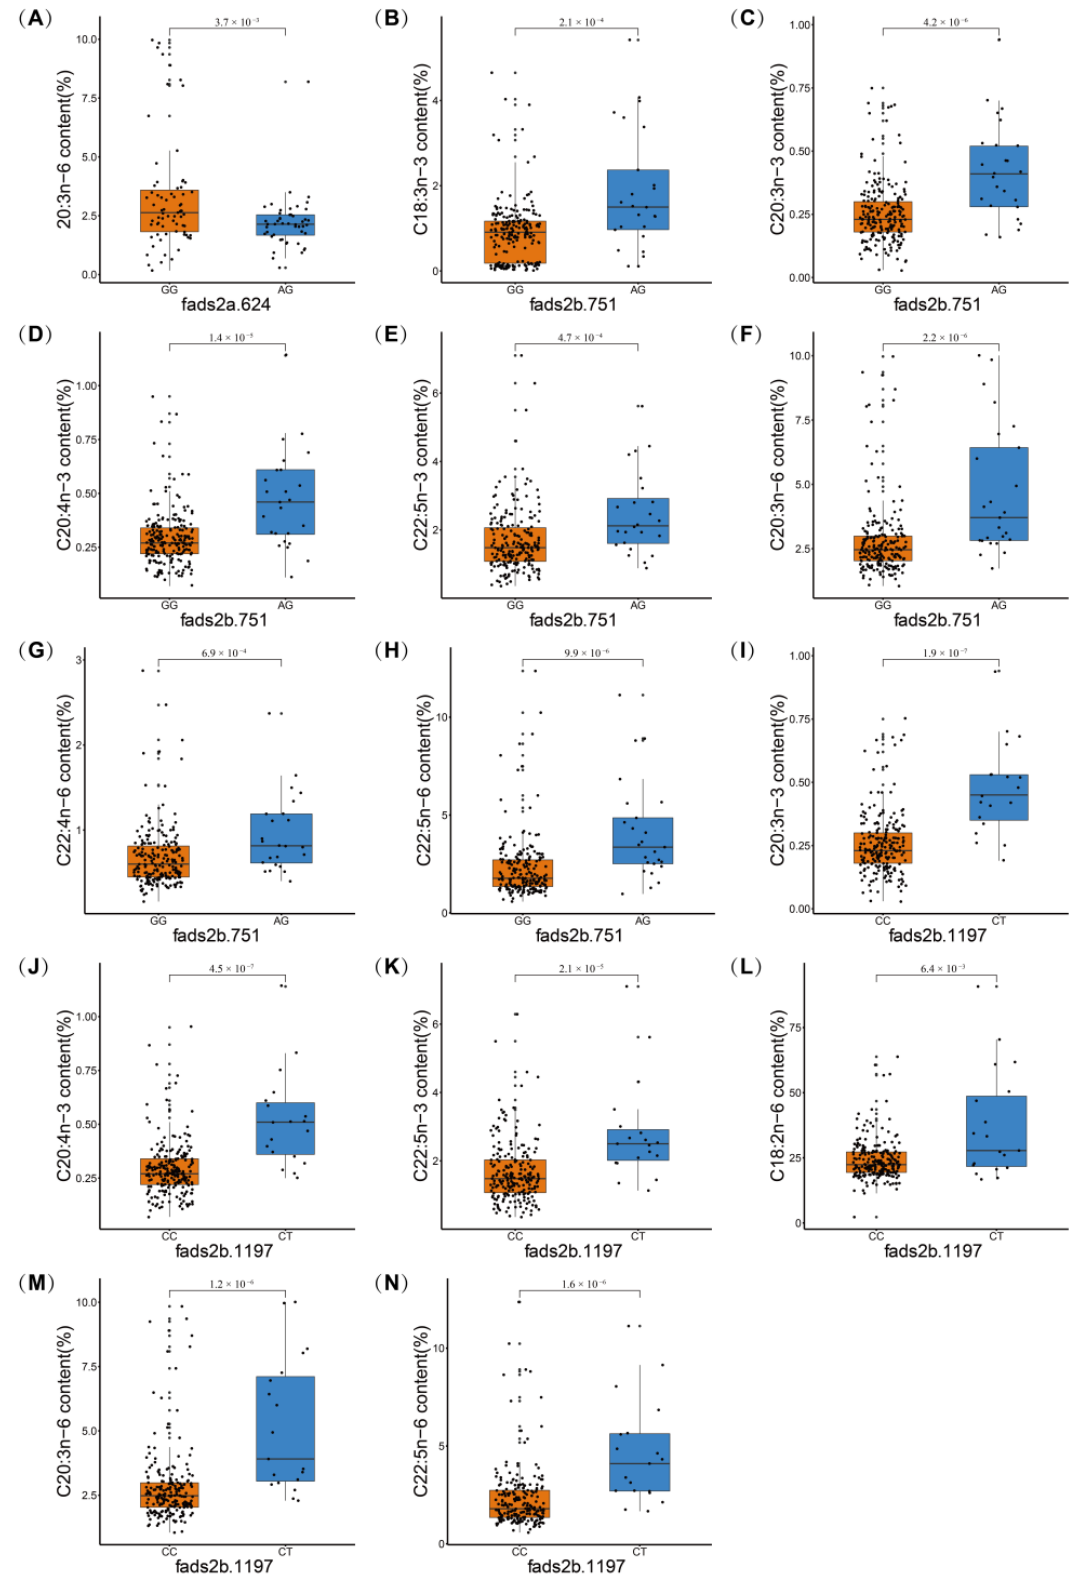
Figure 3. Box plots show significant PUFA content differences between two genotypes in one locus. A : fads2a.624; B – H : fads2b.751; and I – N : fads2b.1197. The correlated p value calculated with ANOVA indicates a significant difference between two groups.